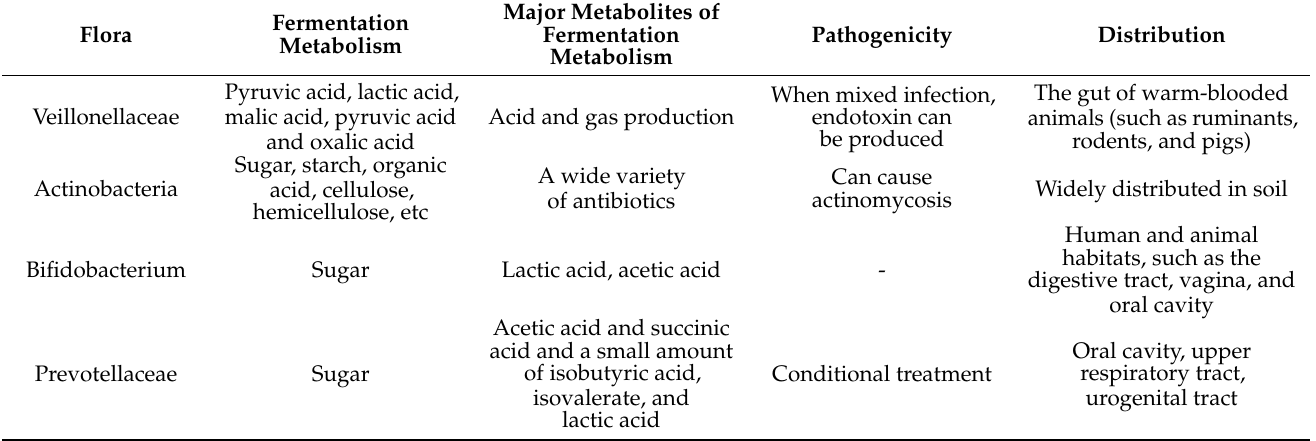
Table 9. Other characterization of differential